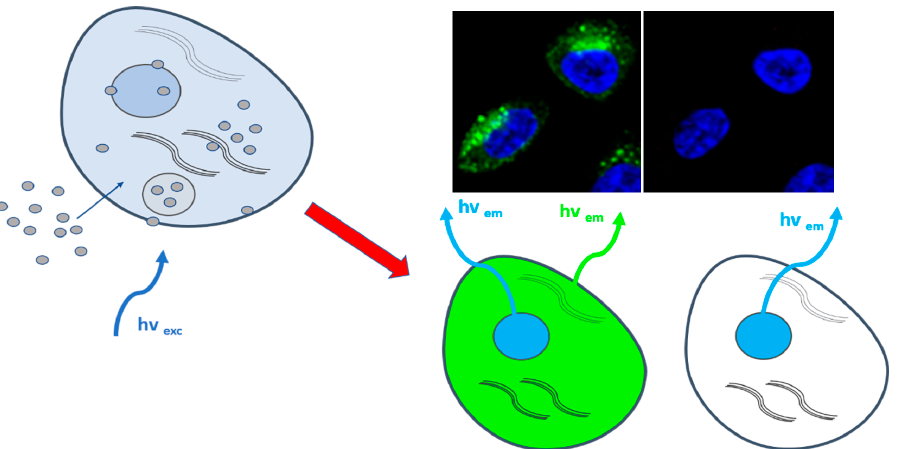
Figure 2. Illustration of CDs cellular internalization for bioimaging. Left part: sketch of a cell depicting CDs penetrating the cell membrane and accumulating in the cytosol (gray circles on the left); right part: sketch of representative fluorescent green staining by intracellular CDs (cell nuclei in the image are stained with DAPI